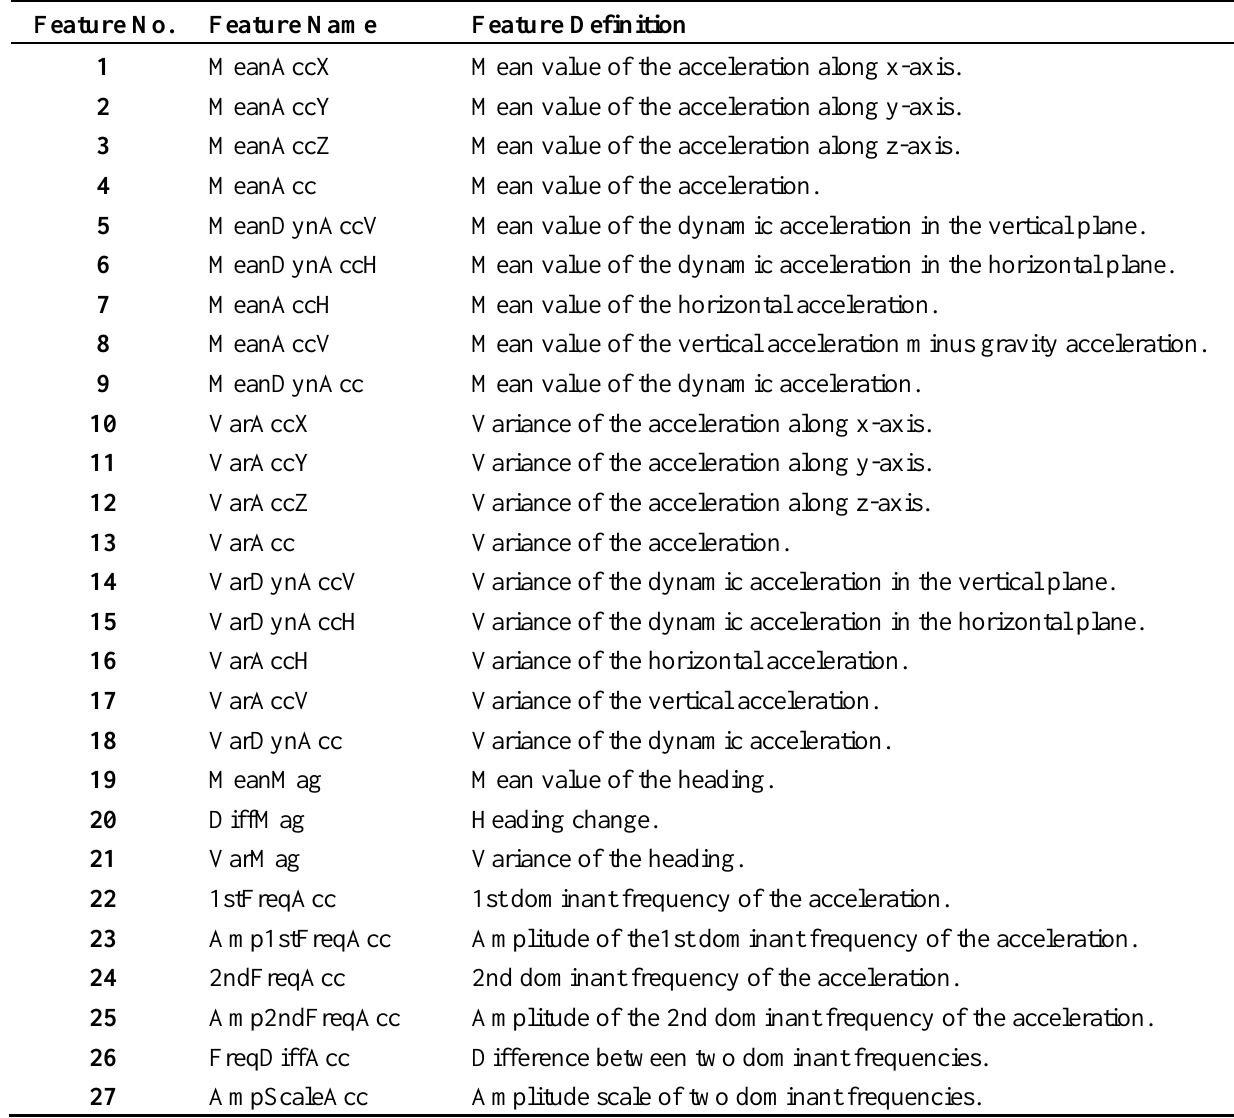
Table 2. Feature